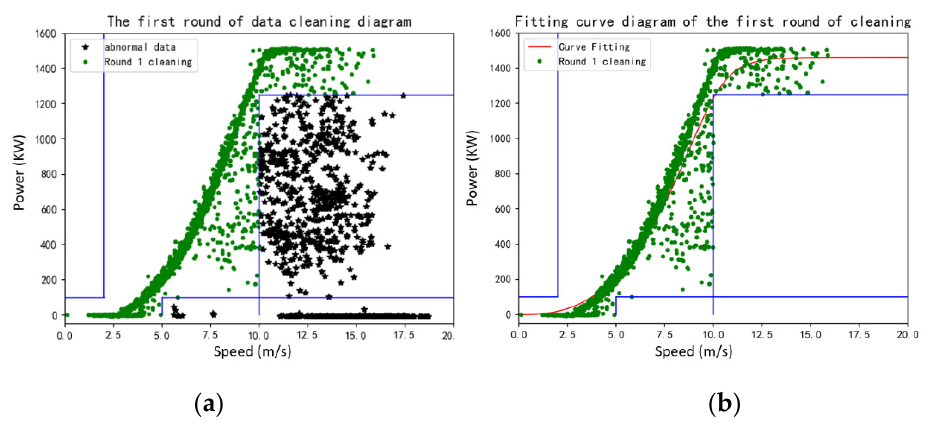
Figure 8. Same as Figure 7, but for the first round of data cleaning and power curve fitting. The blue line is the “power curve impossible” data detection line. labels ( a ): Areas (blue frames) of “power curve impossible” data (black dots) are marked and removed; labels ( b ) power curve fitting (red curve) after removing the bad data. ( a ) The first round of data cleaning diagram; ( b ) fitting curve diagram of the first round of cleaning. The blue lines enclose the areas of “impossible power curve area” determined